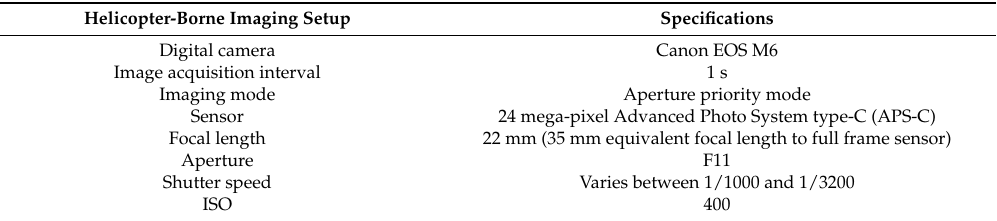
Table 1. Specifications of the helicopter-borne imaging equipment setup.